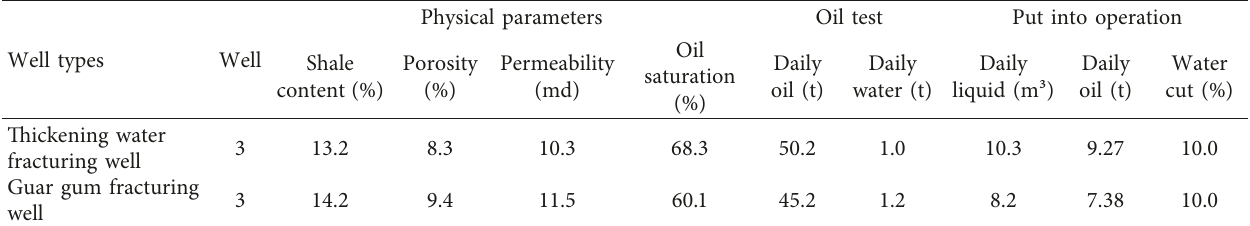
Table 8: Comparison of effect between thickening water fracturing wells and conventional fracturing wells. Well